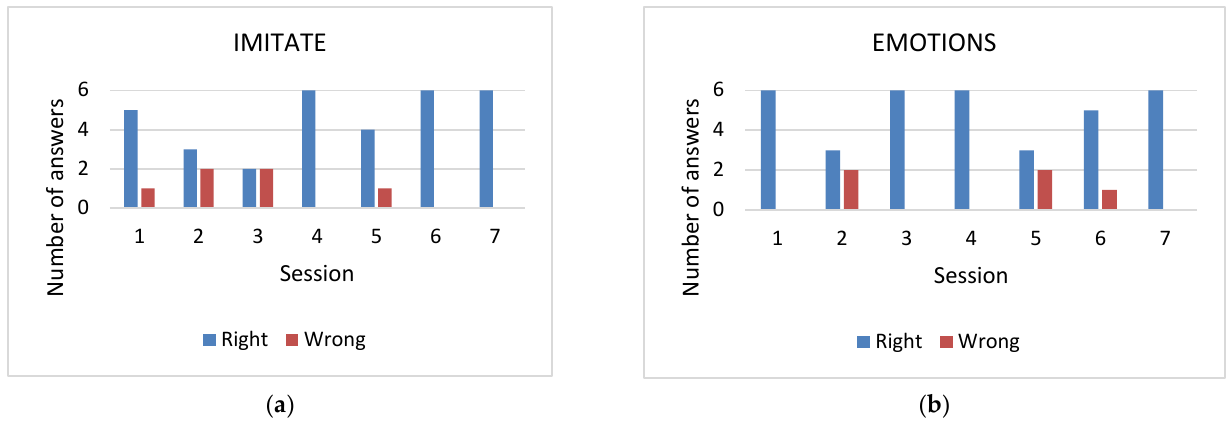
( b ) Figure 9. Child E results — On ( a ), the progress over seven sessions with the IMITATE activity. On ( b ), the progress over seven sessions with the EMOTIONS activity.